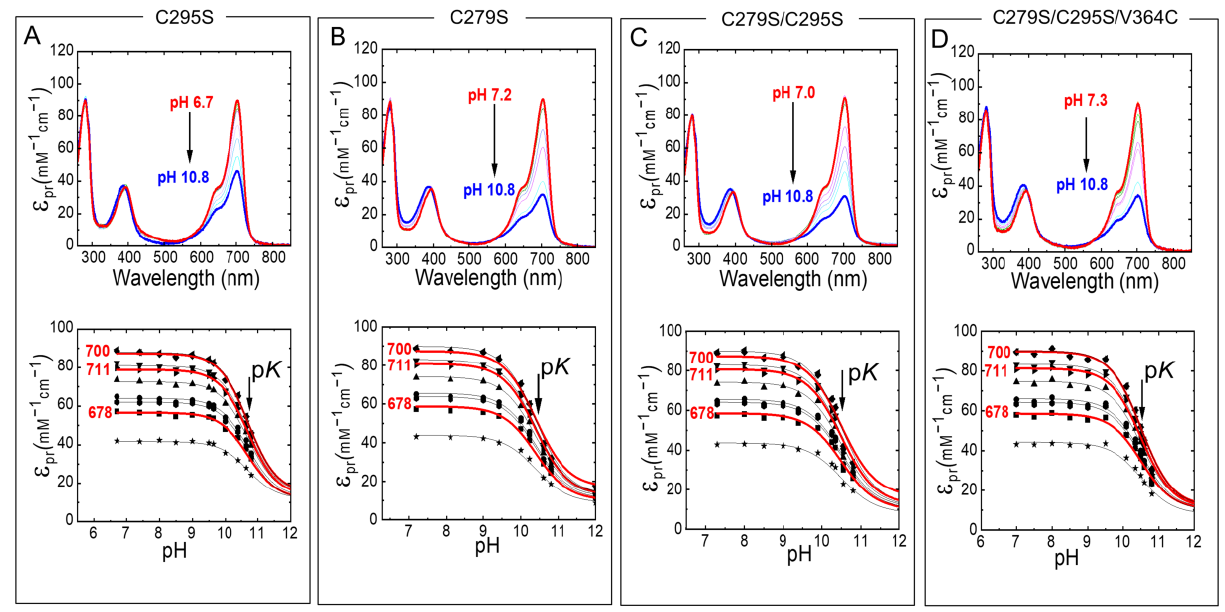
Figure 5. pH-dependent Pr absorption spectra of Agp1-PGP and its variants (top panel). ( A ) C295S, ( B ) C279S, ( C ) C279S/C295S, ( D ) C279S/C295S/V364C. The direction of the pH titration is indicated by the black arrow. The bottom panel shows the respective titration data at nine wavelengths 678 ( ■ ), 683.5 (●), 689 ( ▲ ), 694.5 ( ▼ ), 700 ( ⧫ ), 705.5 ( ◄ ), 711 ( ► ), 716.5 ( ⬣ ), and 722 nm ( ★ ). Selected fit curves at 678, 700, and 711 nm are marked in red. The pH-dependence was fitted by the Henderson − Hasselbalch equation (Equation (2)) using Origin Pro 2019 (Origin Lab). The fit results are summarized in Table 1. The absorption of the deprotonated chromophore at high pH was estimated to 20% of the maximum absorption of the respective wavelength. Conditions: 300 mM NaCl, 50 mM Tris/HCl buffer for pH 6.2–9.5, or 100 mM Na 2 CO 3 /NaHCO 3 buffer for pH 9.5–10.8, at 20 °C.